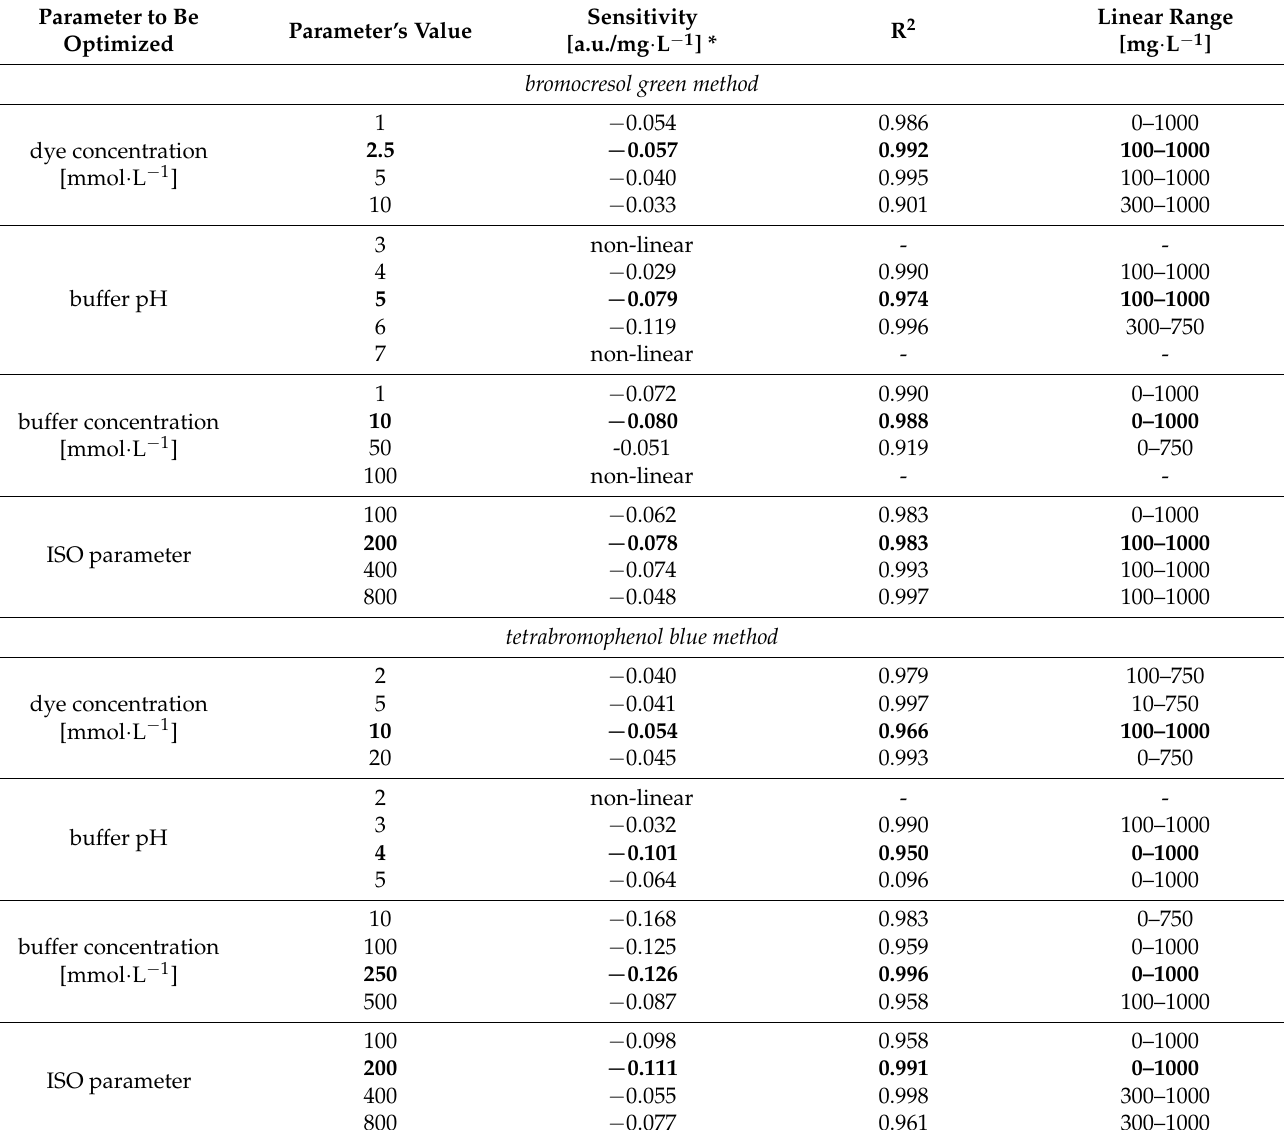
Table 2. The results of the assays’ optimization experiments. The selected optimal parameter is highlighted in